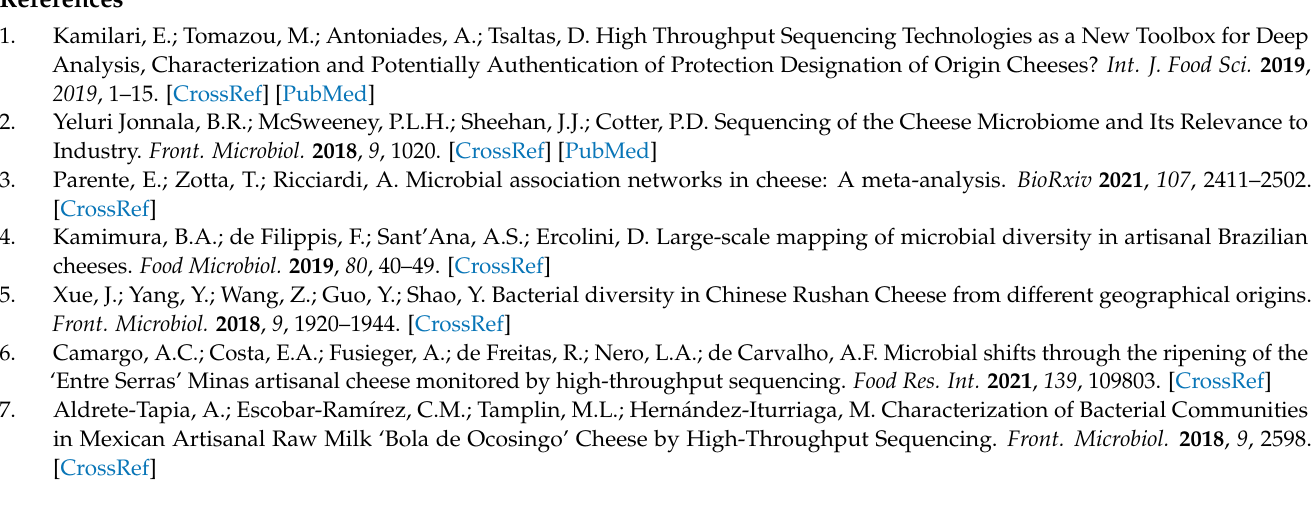
Table S3. Comparison of the alpha microbial diversity of Cyprus, Greece, and Ireland, based